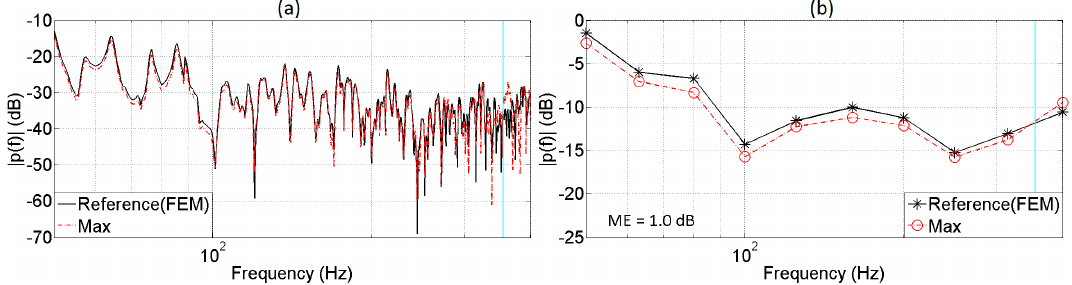
Figure 26. Comparison of full ( a ) and 1/3 octave band ( b ) frequency responses. Translated PWE ( X ) and reference ( X ) at translated Position